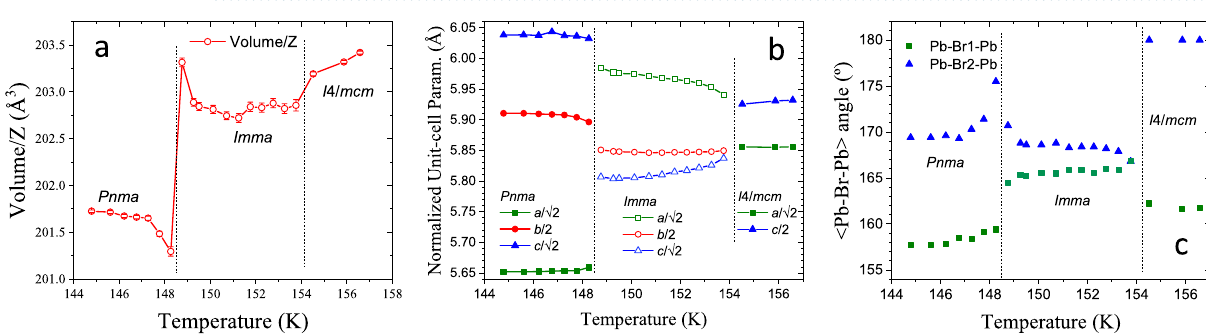
Figure 12. Thermal evolution in the 144–156.5 K range, comprising the Pnma-Imma and Imma-I 4/ mcm phase transitions of ( a ) the unit-cell volume/Z, ( b ) normalized unit-cell parameters and ( c ) the Pb–Br1–Pb and Pb– Br2–Pb